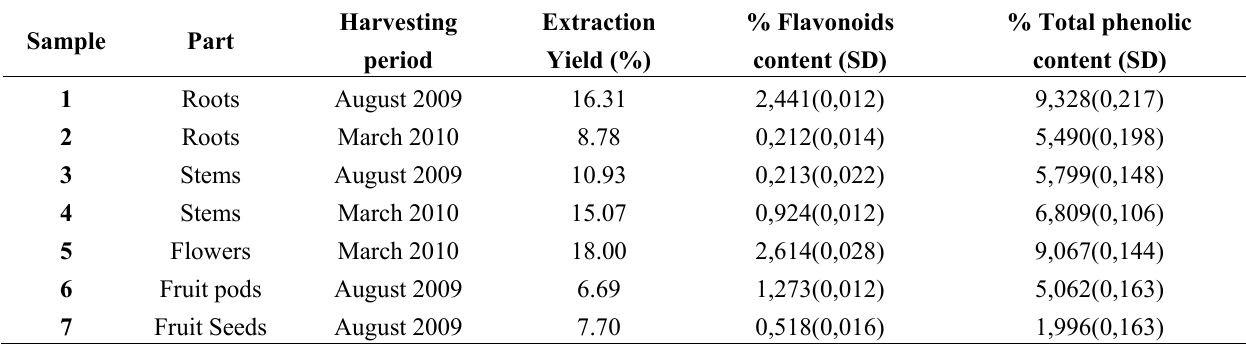
Table 1. Measured phenolic and flavonoid content of each extract.